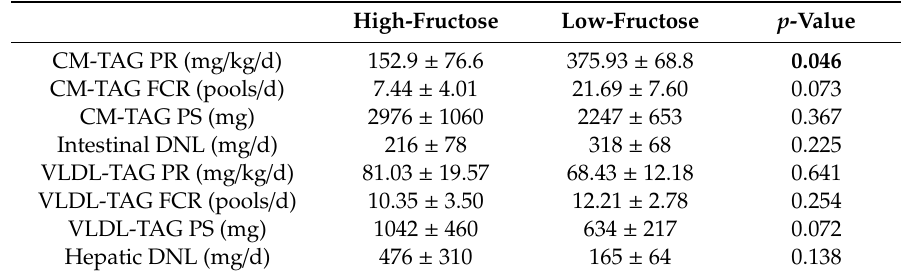
Table 2. Postprandial CM-TAG and VLDL-TAG kinetics and DNL in response to high- and low-fructose drinks. Values are mean ± SEM ( n =